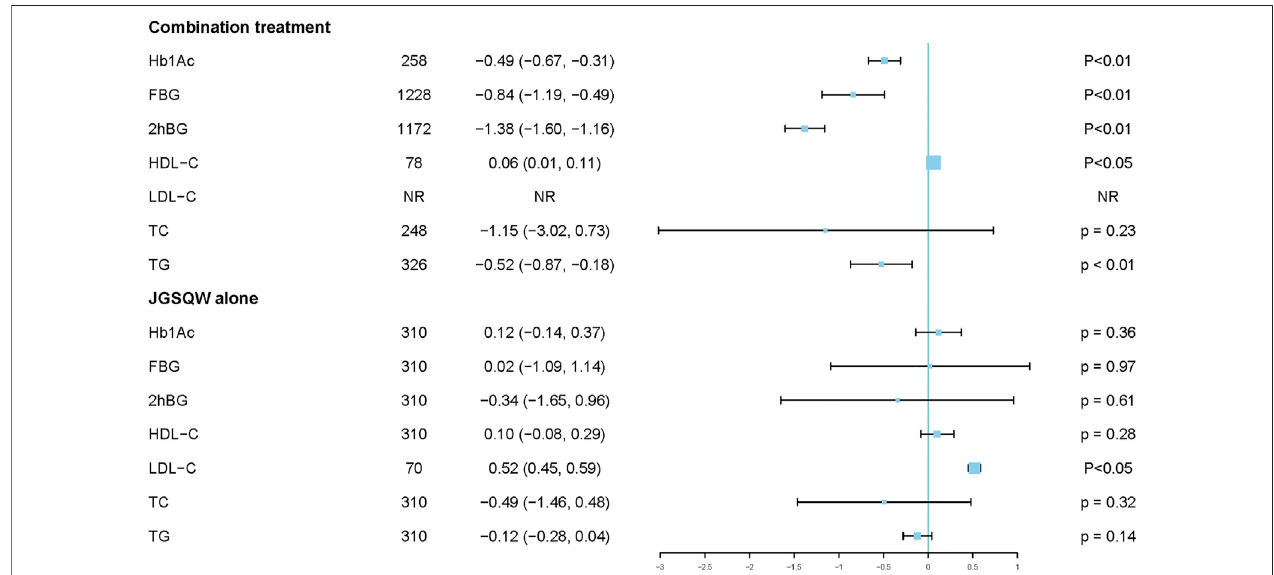
FIGURE 4 | Summary of the main fi